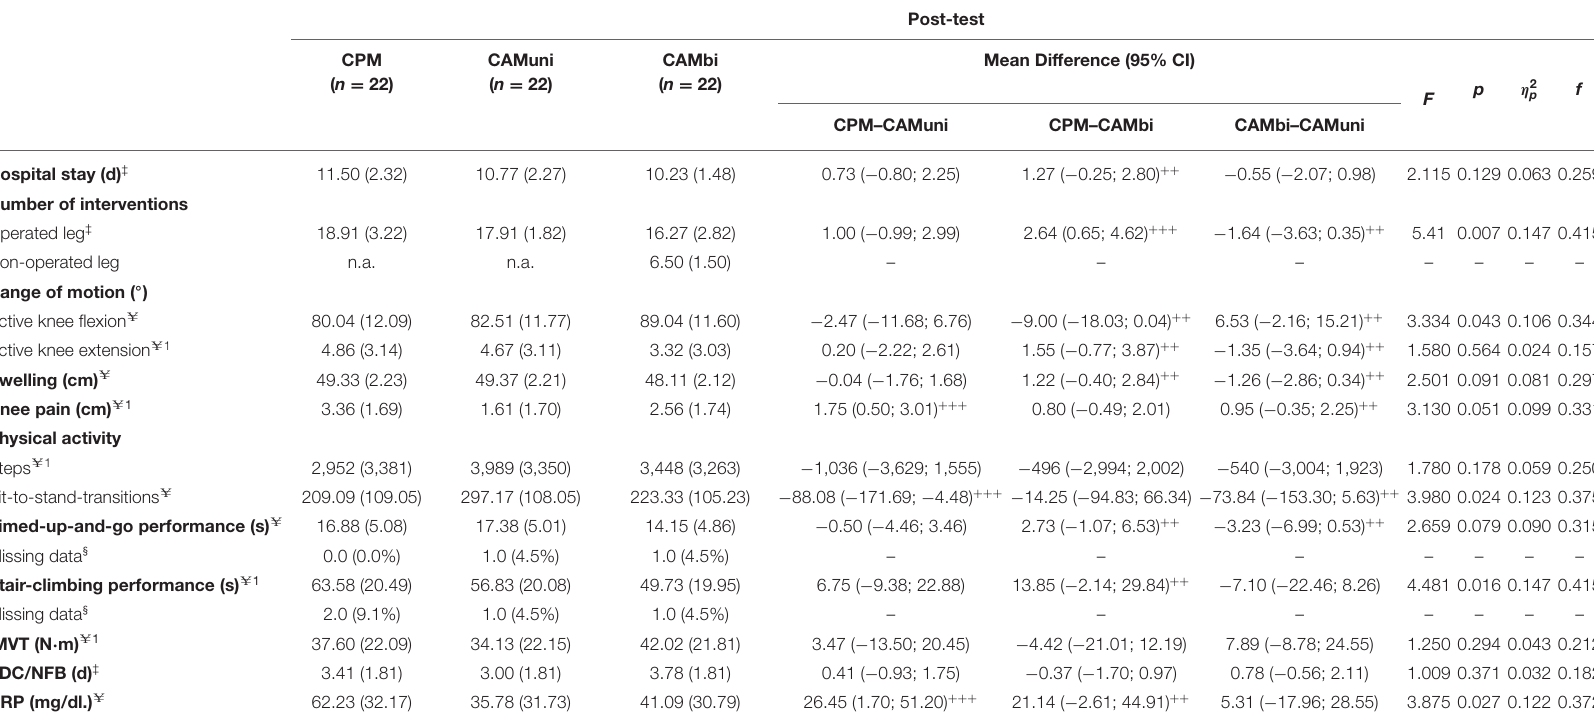
TABLE 3 | Measures of clinical, functional, and quality of life outcomes at post-test (modified intention-to-treat